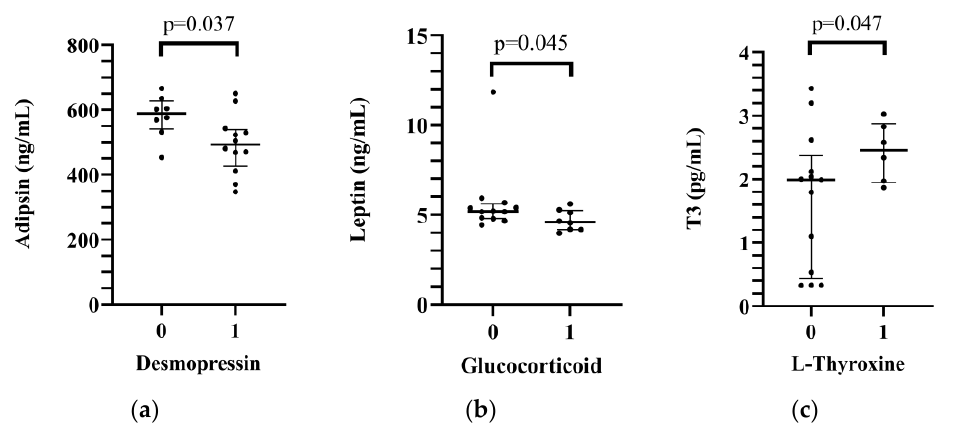
Figure 2. Relationship between donors’ desmopressin ( a ), glucocorticoid ( b ) and L-thyroxine ( c ) replacement therapy and the pericardial immune profile.